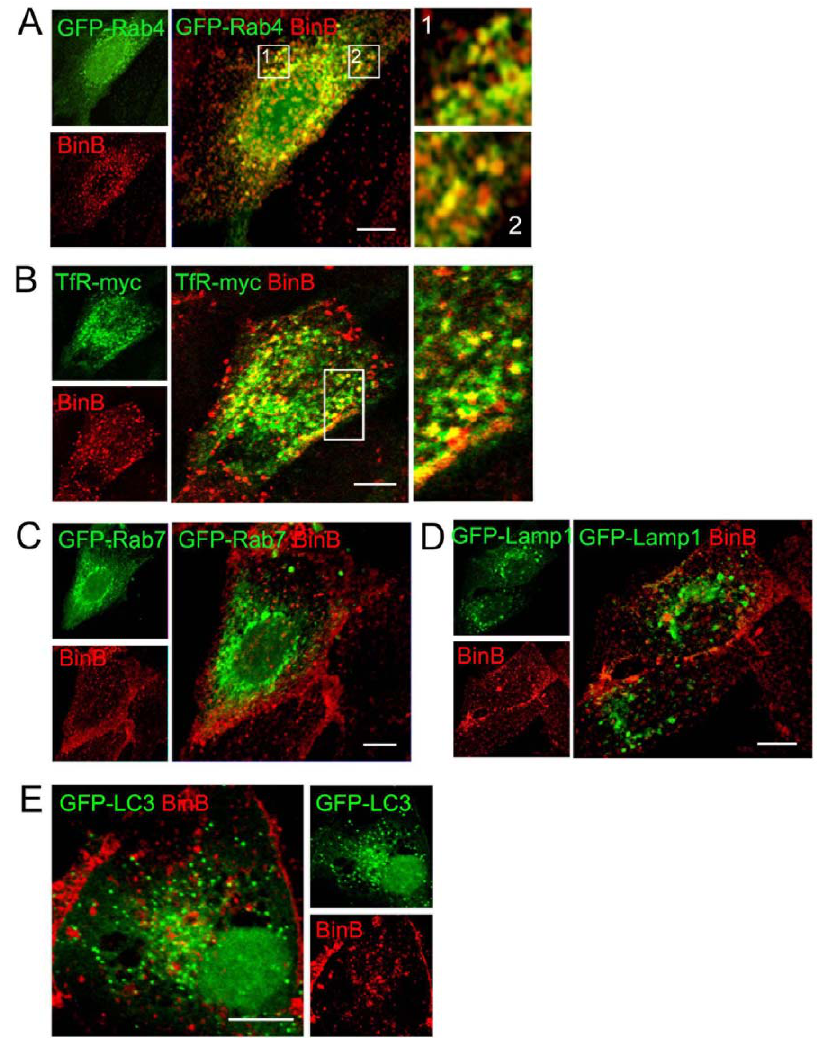
Figure 6. After internalization, Bin reaches recycling endosomes. MDCK-Cpm1 cells were transfected with markers of early and late endocytotic compartments, intoxicated with a mixture of unlabelled BinA and BinB-Al 543 for 30 min and processed for confocal microscopy analysis. (A) BinB-Al 543 fluorescent signal colocalized with GFP-Rab4, a typical marker of recycling compartments. (B) A significant colocalization was detected with TfR-myc that marks both endocytotic and recycling vesicles. (C - E) No colocalization was found with GFP-Rab7 and GFP-Lamp1 that marks late- endocytotic/lysosomal compartments and GFP-LC3 a marker of autophagic vesicles. Bars, 10 m m.